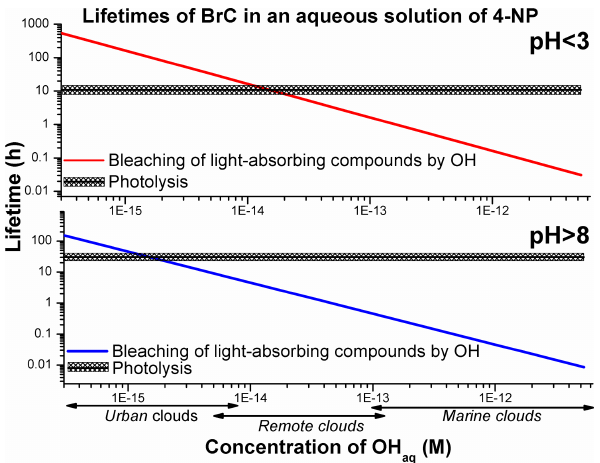
Figure 6. The estimated aqueous-phase lifetimes of light-absorbing compounds in solutions of 4NP and 4NPT. The lifetimes due to the reaction with OH were calculated with k bleaching rate constants derived with Eq. (3) using the experimental data acquired in this study. The average lifetime due to photolysis is shown, and shaded areas are 2 σ values, representing the range of photolysis lifetimes calculated for the solar zenith angles 0–50 ◦ .